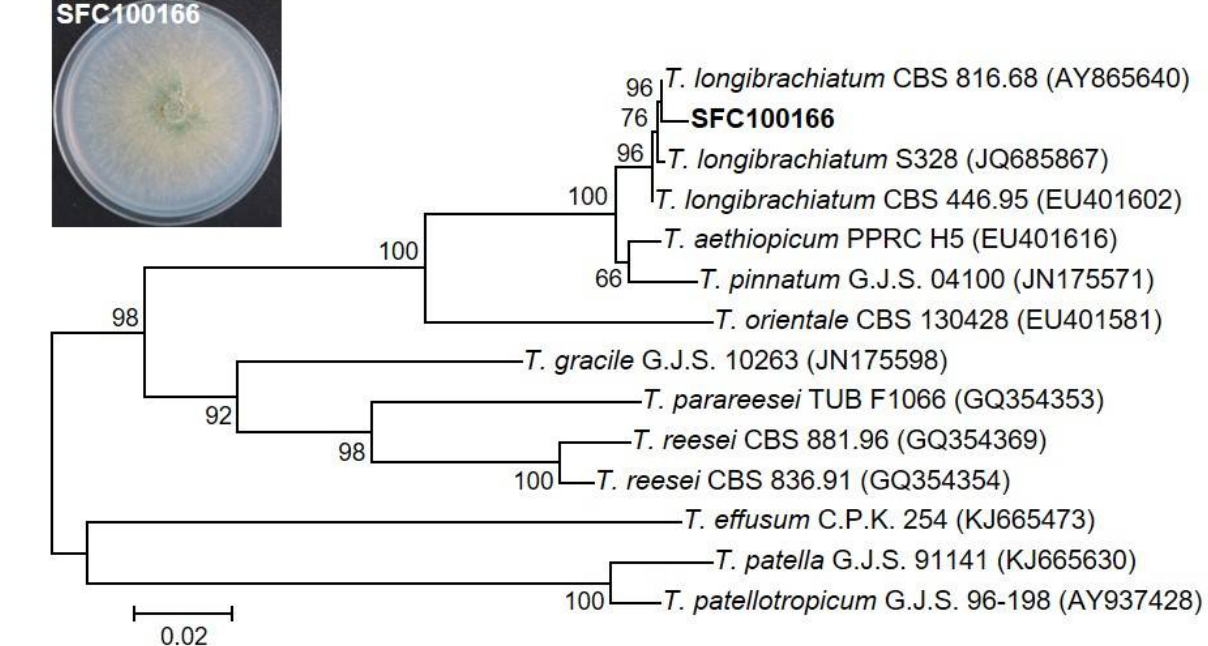
Figure 1. Phylogenetic analysis of the SFC100166 isolate. An inset box showed the SFC100166 isolate culture grown on PDA. Phylogenetic analysis by the neighbor-joining method was performed based on the translation elongation factor 1-α ( TEF1 ) gene sequences of SFC100166 and the other 13 Trichoderma species. NCBI accession numbers of each sequence are in parentheses. The scale bar indicates the number of nucleotide substitutions per site.